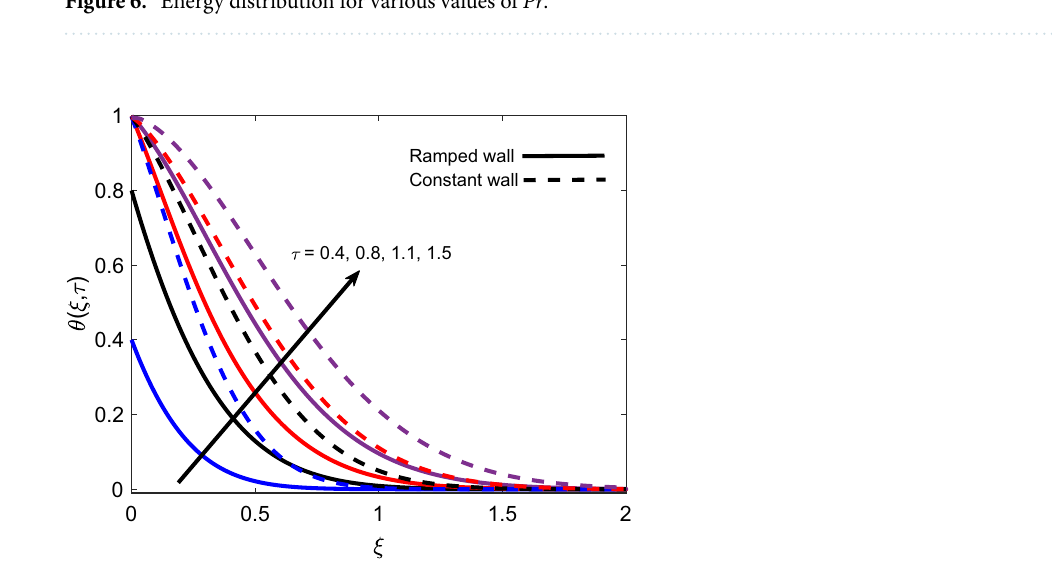
Figure 6. Energy distribution for various values of Pr .